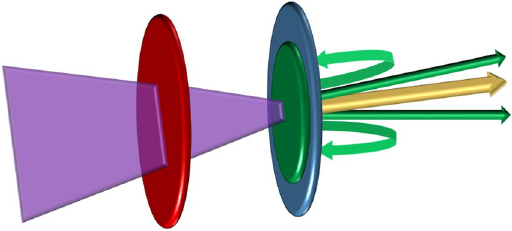
Figure 3. A pictorial representation of the proposed modification to the ZVP mechanism to include QED effects. The original pseudo-capacitor, characterised by a displaced electron fluid (blue) and a consequent region of net positive space charge (red) is augmented by pair production at the peak intensity of the incident laser pulse (faded purple) on the negative “plate”. The positrons (yellow), not feeling a restoring force, propagate into the bulk plasma and leave the region of interest. In contrast, some of the pair-produced electrons (green), are subject to a restoring force which keeps a fraction of them within the region of interest, thus increasing the net charge in the region of the original negative